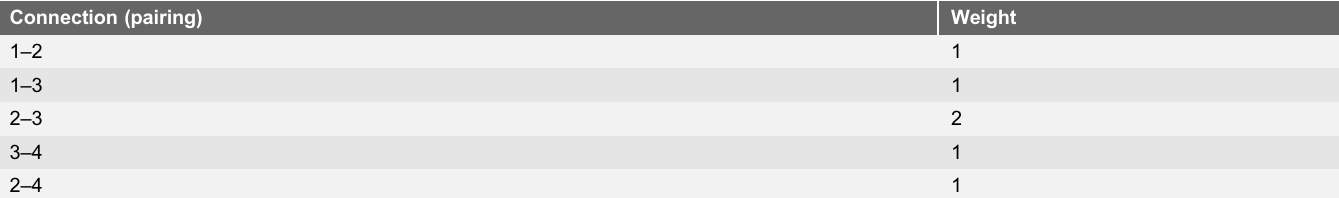
Table 4. Example of weight assignments for specific pairings represented multiple times.